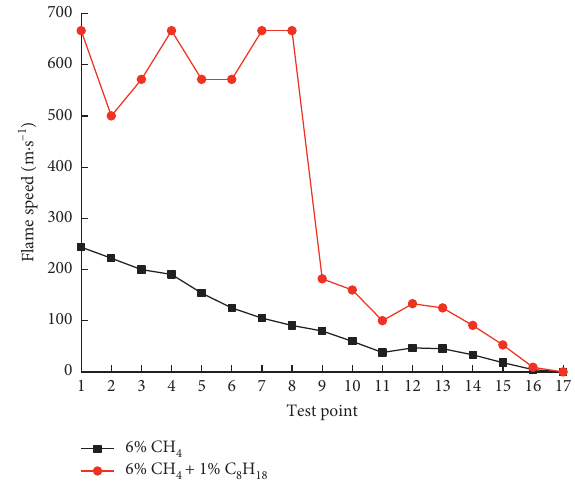
Figure 16: Curves of flame propagation velocity under different gas